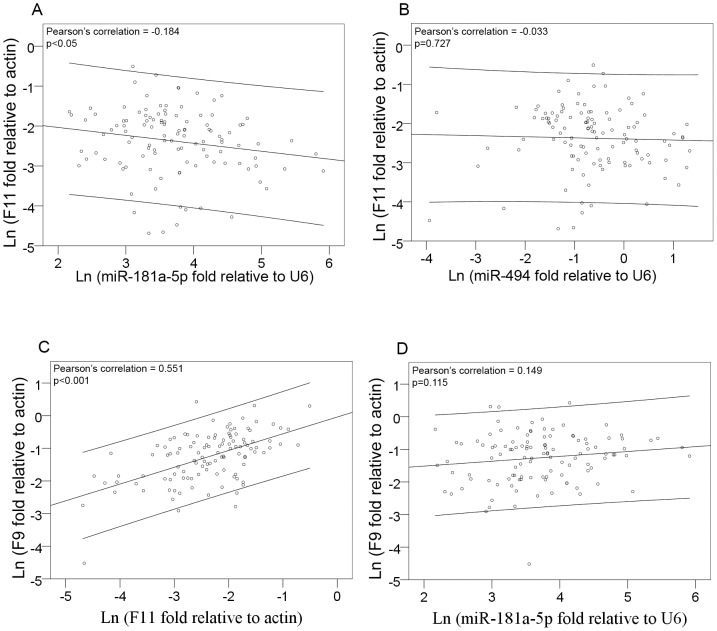

Ex vivo expression of F11 mRNA and mature miRNAs.Linear regression analysis between endogenous mature miRNAs (miR-181a-5p and miR-494) levels and F11 mRNA (A & B respectively). (C) Linear regression between F11 and F9 mRNAs and (D) between miR-181a-5p and F9 mRNA. qRT-PCR were performed in total RNA purified from healthy livers (n = 114). Statistical significance was taken as p<0.05. The results are presented as Ln fold change with respect to the normalization standard.